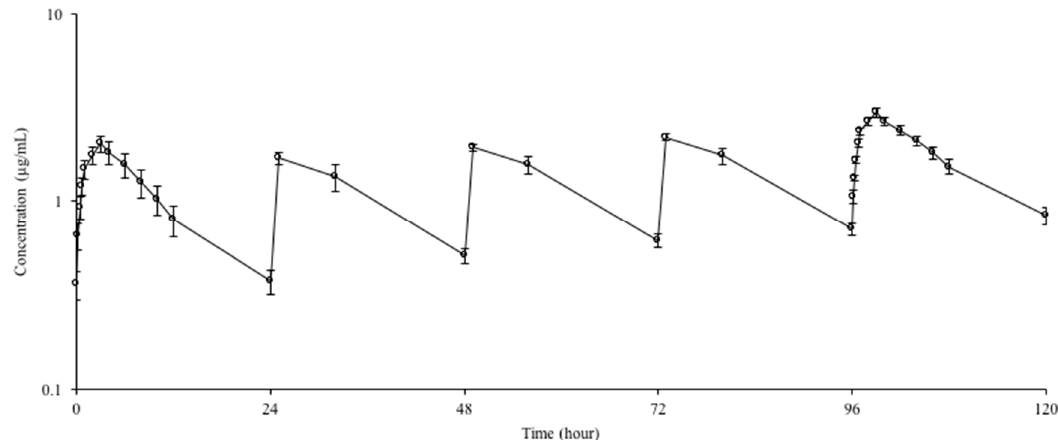
Figure 2. Semi-logarithmic plasma concentration–time curves of doxycycline hyclate following repeated oral administrations at the dose of 20 mg/kg every 24 h for 5 days in goats ( n = 6, mean ± SD). Table 2. Plasma pharmacokinetic parameters of doxycycline hyclate following repeated oral administrations at the dose of 20 mg/kg every 24 h for 5 days in goats ( n = 6, mean ± SD).